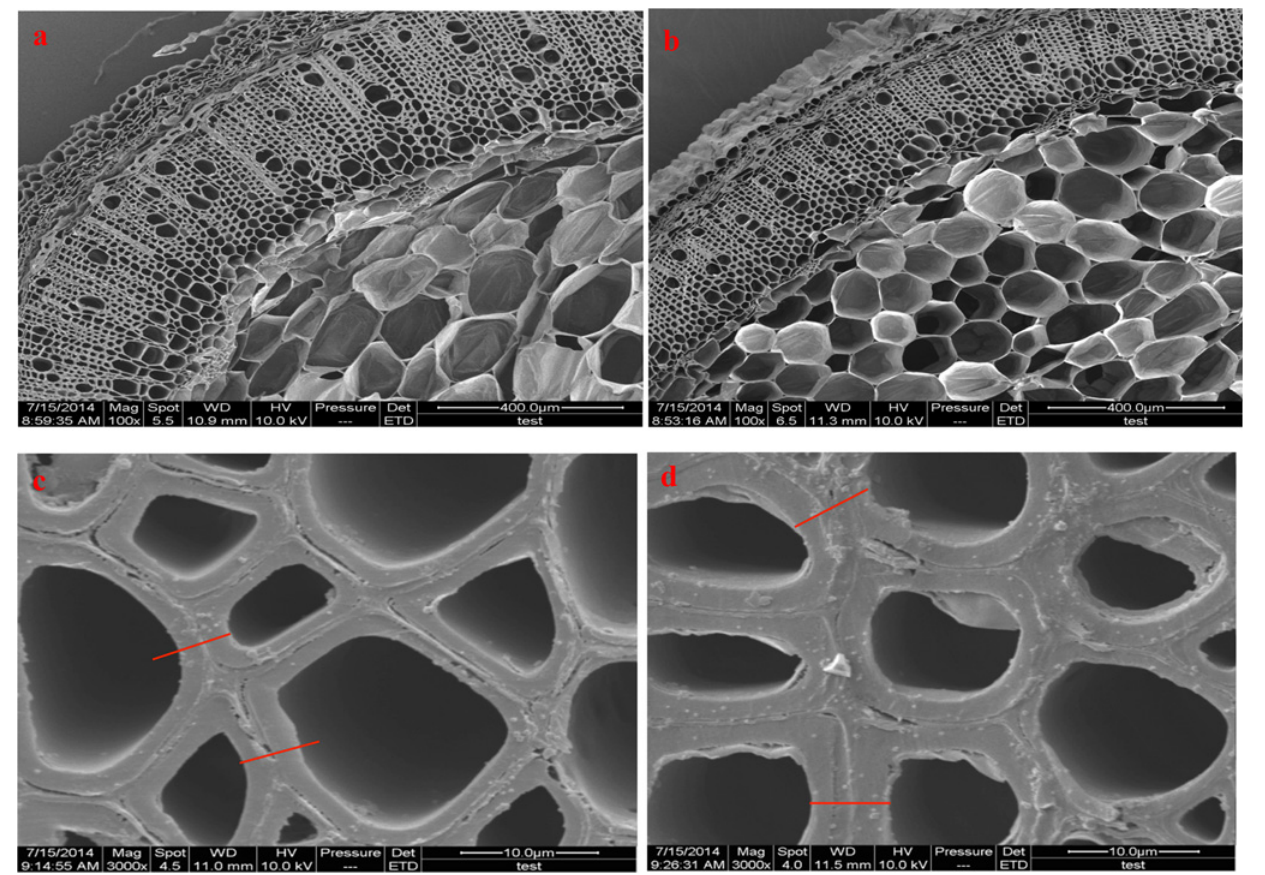
Fig 7. Scanning electron micrographs of the PI5 – 8 stem transverse sections of three-month-old tobacco transgenic lines. a. and c were from wildtype tobacco plants. b. and d are the L15 PsnSusy2 tobacco transgenic line. Short red lines in Figure c and d depict the difference between the cell wall thickness in the tobacco transgenic lines and the wildtype plants. The magnification factor is 100X for Fig. 7a and 7b, and 3000X for 7c and